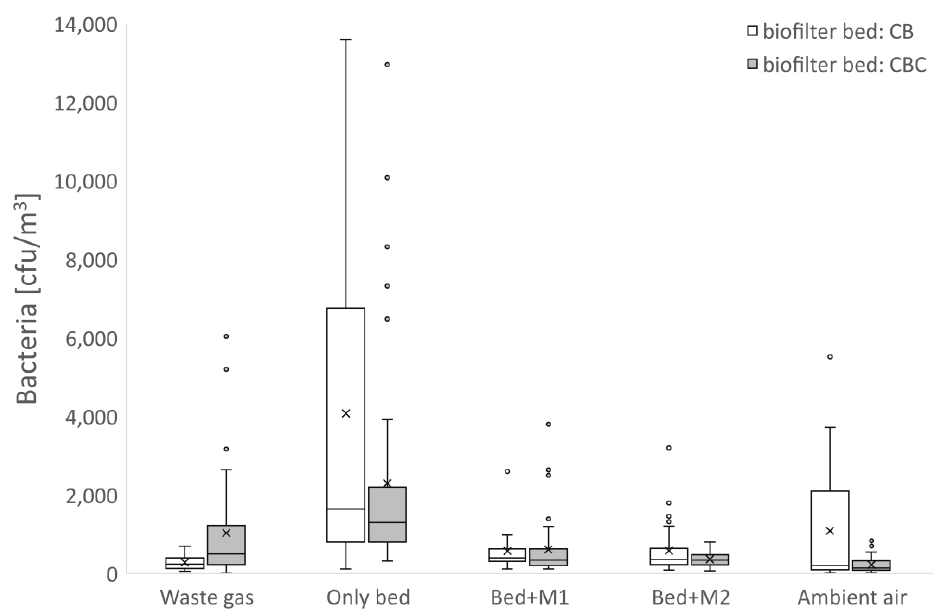
Figure 3. Total number of bacteria [cfu/m 3 ] in the waste gas, gases treated by a conventional biofilter (only bed) and combined biofilter (bed + membrane M1 or M2), and the ambient air. Types of bed materials: CB—mix of stumpwood chips and pine bark; CBC—mix of stumpwood chips, pine bark, and compost from green waste. The band inside the box—median; ×—mean value; ○ —outliers.